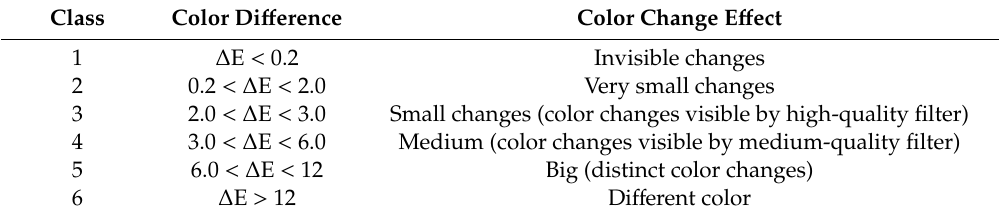
Table 1. Color change class [16,17].